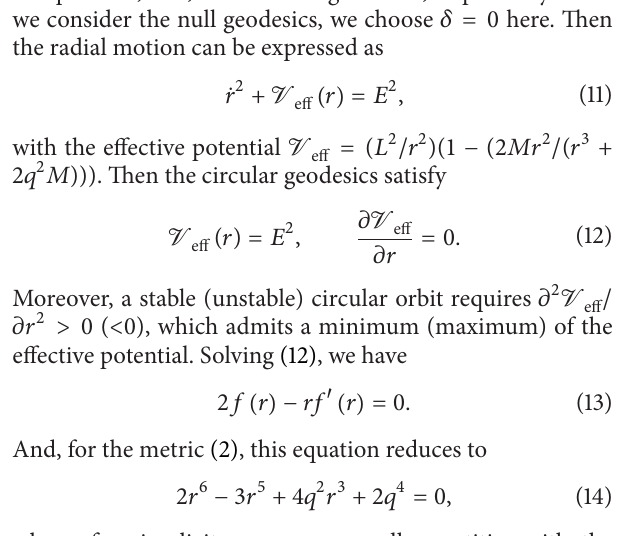
Figure 1: Horizons and circular orbits for the nonsingular space- time. The thin solid and dashed lines are for the outer and inner horizons, respectively. And the thick solid and dashed lines are for the photon sphere and stable circular orbit, respectively. The = (2√3)/9 = 0.385 and 𝑄 = (25√30)/288 = parameters 𝑄 cr 1 cr 2 0.475